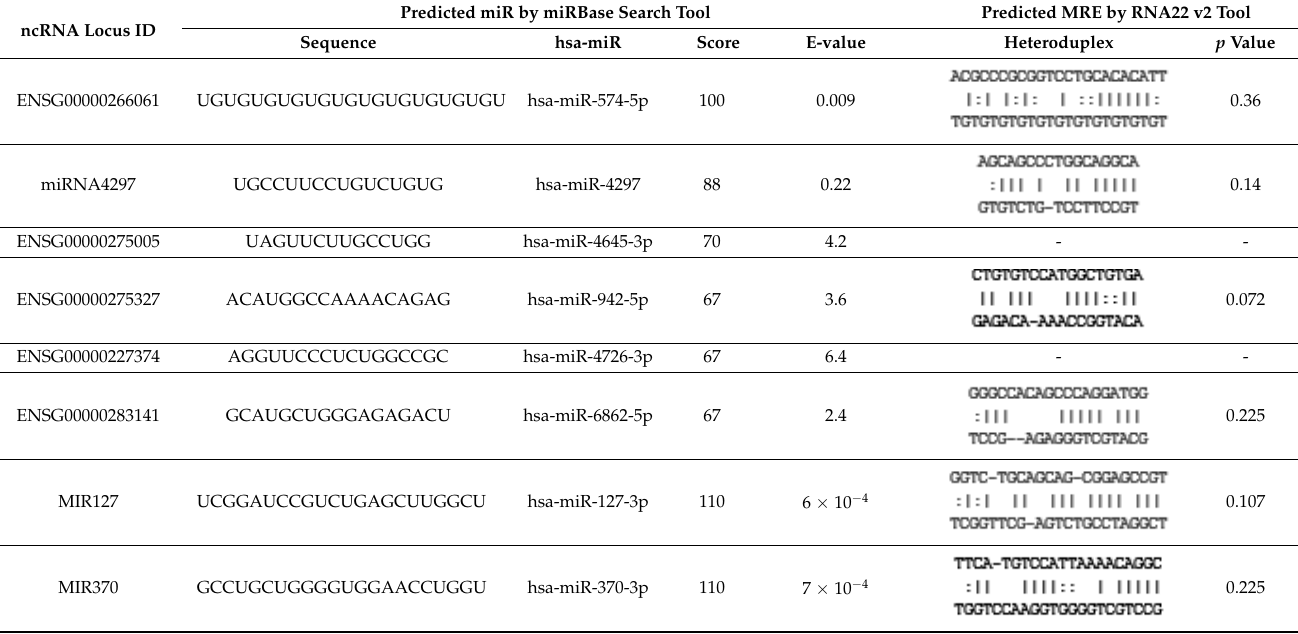
Table 4. Identification of miR sequences in noncoding RNA loci that bind target MREs of MGMT (NM_002412.4) mRNA transcript. Prediction of the mature miRNA sequence of a miRNA/ncRNA transcript by miRBase search tool and identification of miR binding sites of MGMT (NM_002412.4) microRNA recognition elements (MRE) and their corresponding heteroduplexes by RNA22 v2 microRNA target detection tool. Analysis conducted for prediction of mature sequences (miR) of miRNA loci (predicted ENSG00000266061 and miRNA4297), antisense RNA (ENSG00000275005 and ENSG00000275327), lncRNA (ENSG00000227374 and ENSG00000283141). MIR217 and MIR370 which are known to downregulate MGMT expression [79,85] were included for comparison. The upper sequence in the heteroduplex represents MRE for MGMT mRNA. The lower E-values and p-values mean the greater chance that the loci contains a valid MRE.